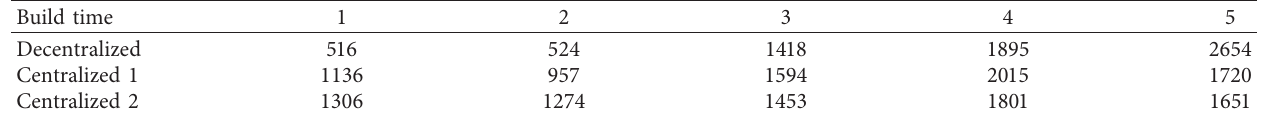
Table 3: Rate comparison (data node).